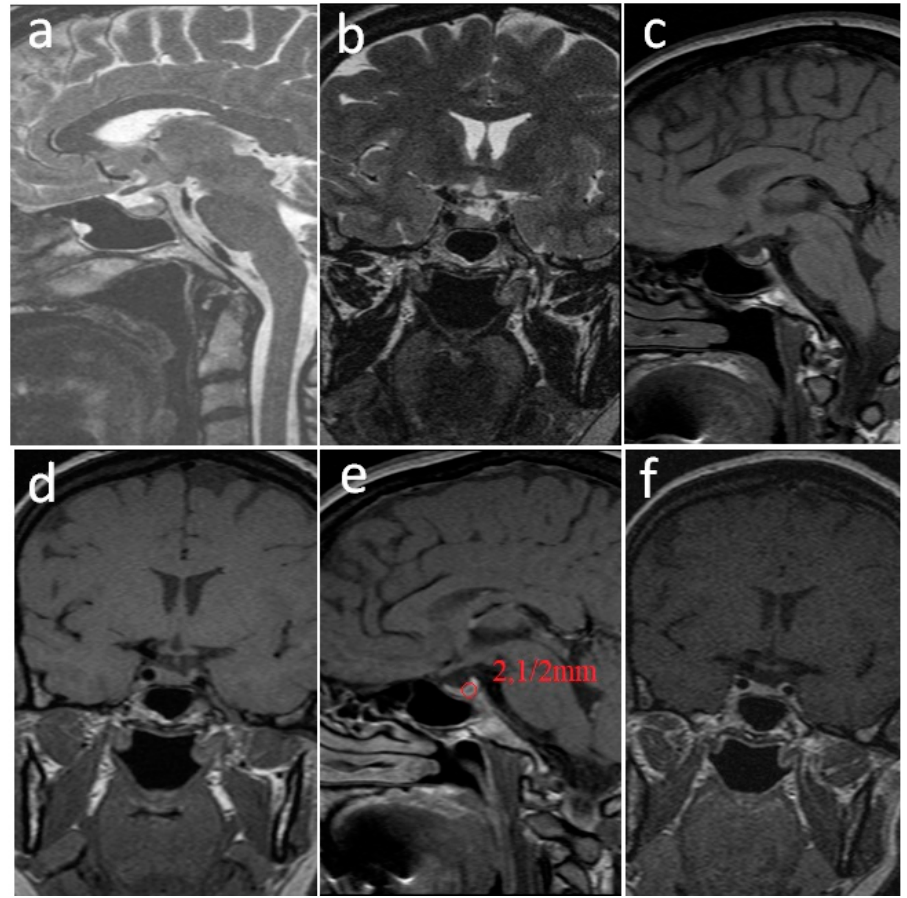
Figure 2. Pituitary MRI performed 4 years later when the patient was 6 weeks pregnant. ( a ). Non-contrast sagittal T2-weighted image. ( b ). Non-contrast coronal T2-weighted image. ( c ). Non-contrast sagittal T1-weighted image. ( d ). Non-contrast coronal T1-weighted image. ( e ). Post-contrast sagittal T1-weighted image. ( f ). Post-contrast coronal T1-weighted image. Favorable evolution of the pituitary adenoma located in the left parapituitary in moderate high-signal T2-weighted ( a , b ), low-signal T1-weighted ( c , d ), and non-gadolinium enhanced ( e , f ) with dimensions reduced to 2.1/2 mm.